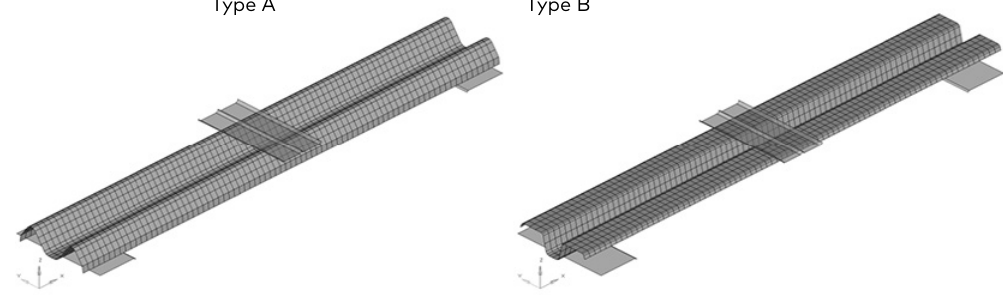
Figure 6. Numerical models of three-point bend systems of validation